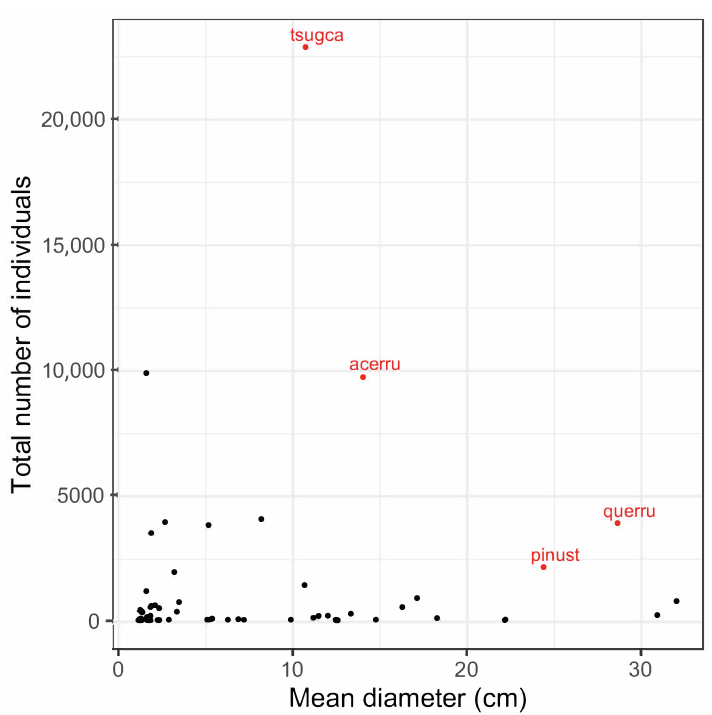
Figure 2. Size-frequency distribution of the 51 living woody species in the Harvard Forest 35-ha plot. Each point is the average diameter of all living stems 1-cm diameter for a single species. The four dominant species (labeled in red; key to abbreviations in Table 1) fall well away from the expected “reverse-J” distribution.